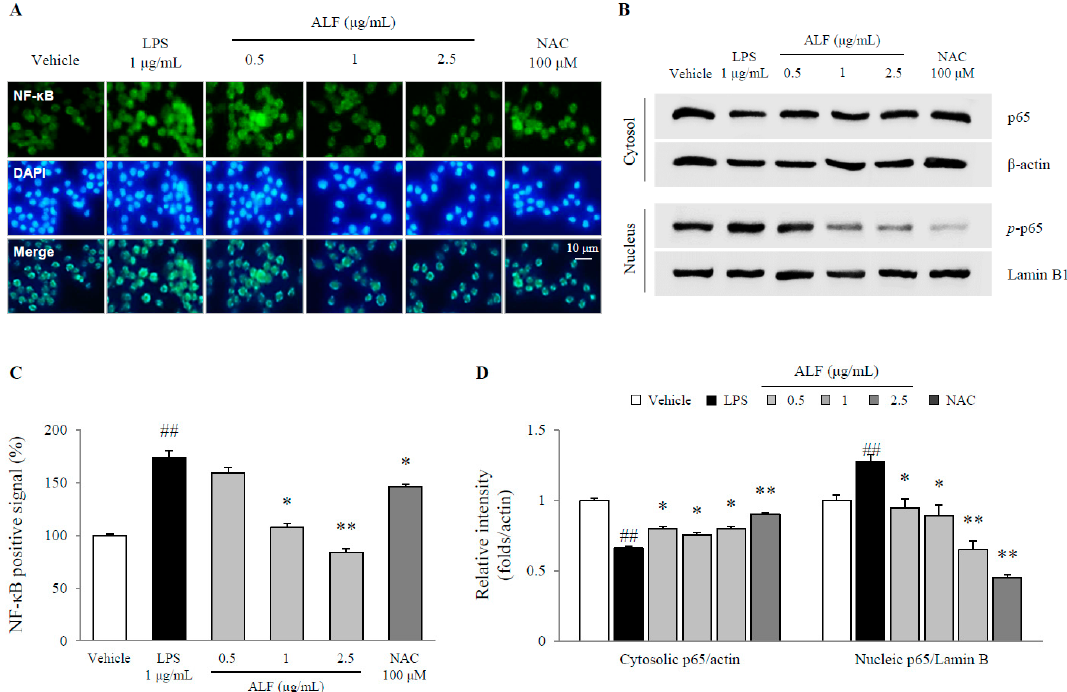
Figure 4. Nuclear factor-kappa B (NF- κ B) signals in BV2 cells. Signals for nuclear translocation of